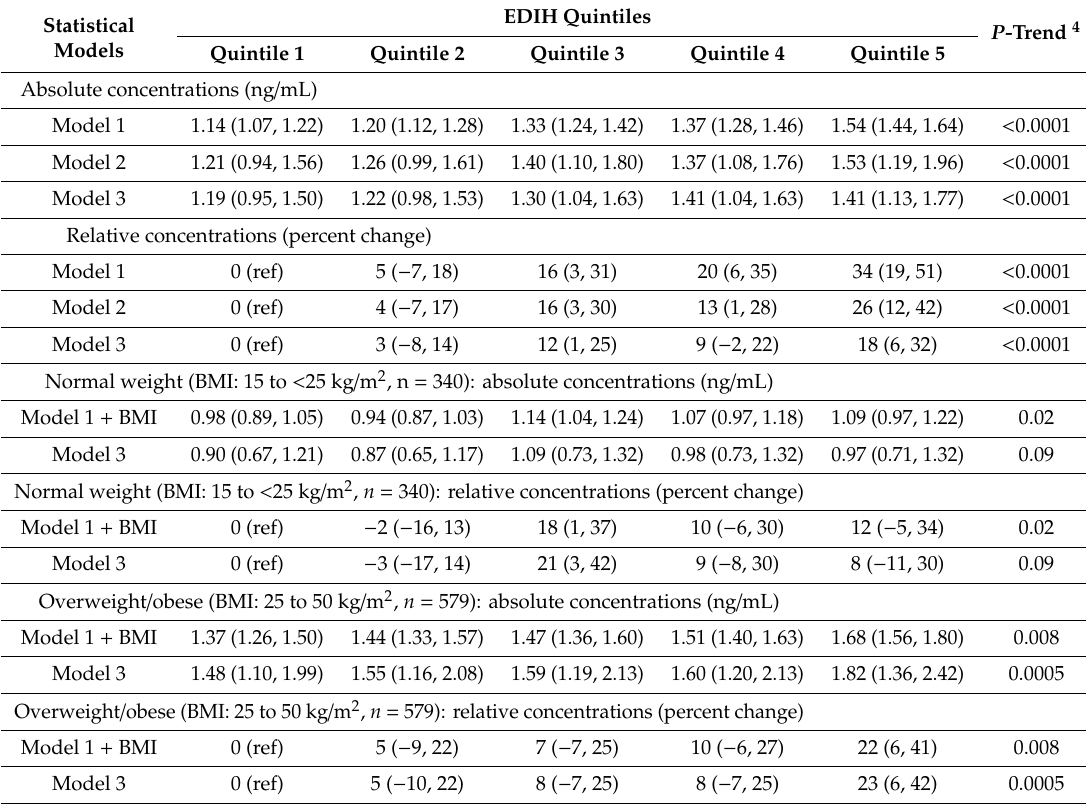
Table 2. Adjusted absolute and relative concentrations (95% CI) of plasma c-peptide in quintiles of